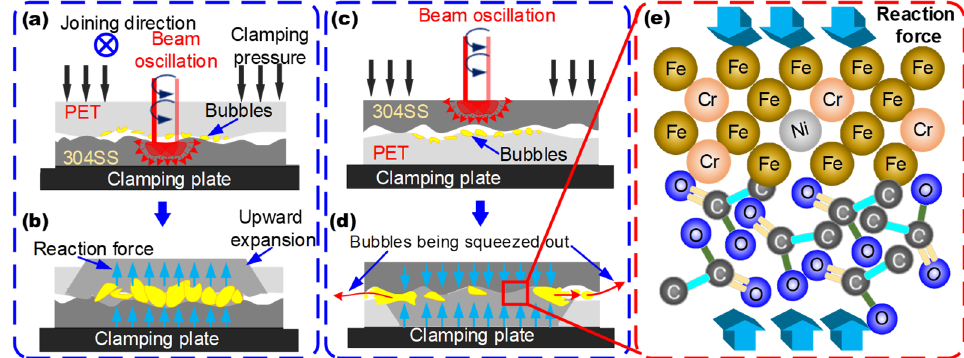
Figure 10. Formation of bubbles and chemical reaction of the interface: ( a ) joining process diagram of O-LTJ, ( b ) bubble force analysis of O-LTJ, ( c ) joining process diagram of O-LCJ, ( d ) bubble force analysis of O-LCJ, ( e ) chemical reaction mechanism of the interface.